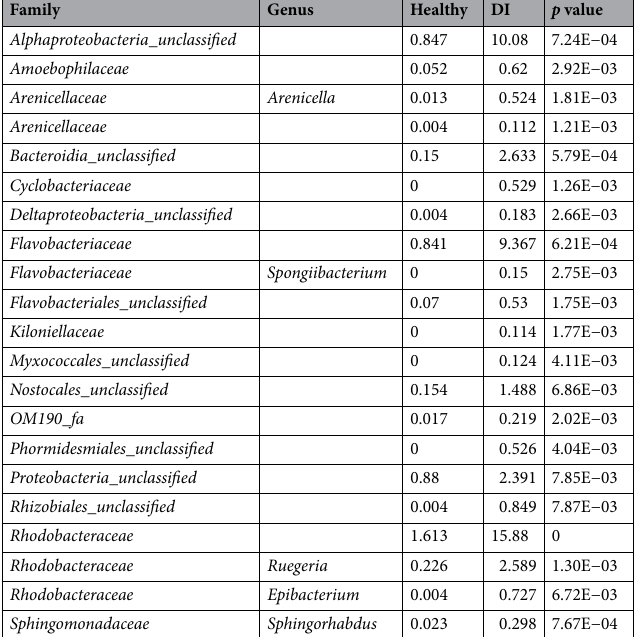
Table 4. Classification of the 21 OTUs found in all colonies presenting necrosis and with a tendency of increasing relative frequency as the disease progresses in the coral Tubastraea tagusensis